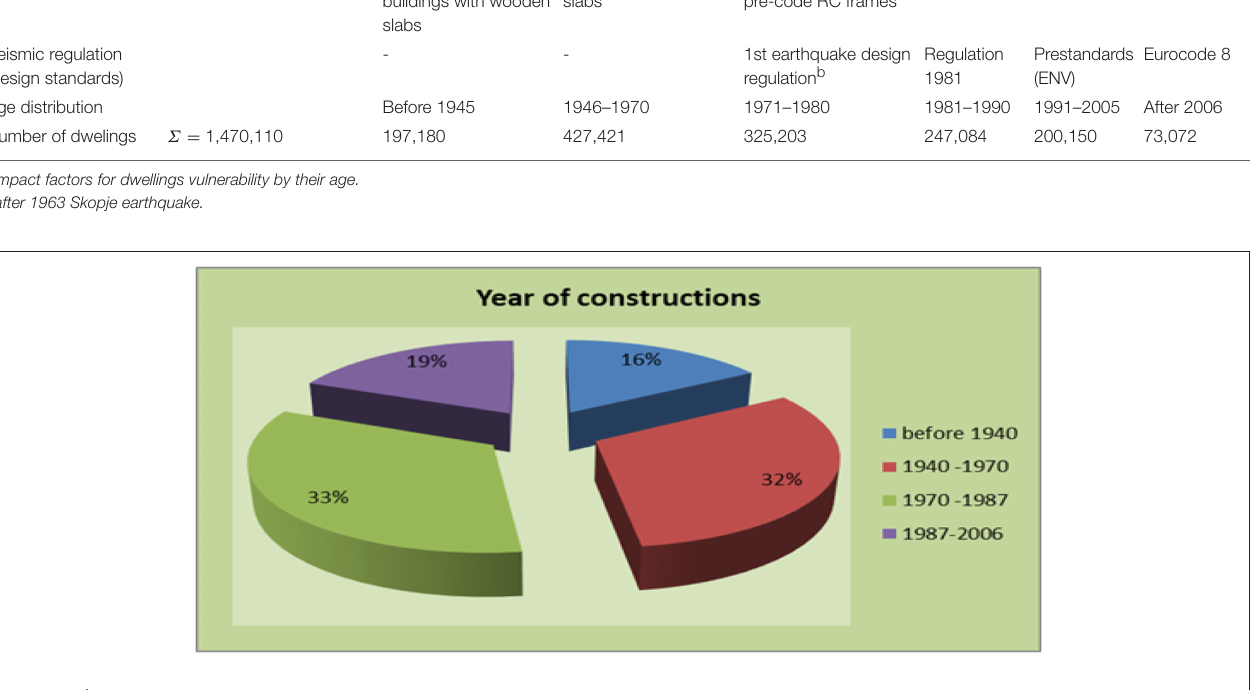
FIGURE 2 | Year of construction for buildings in Osijek